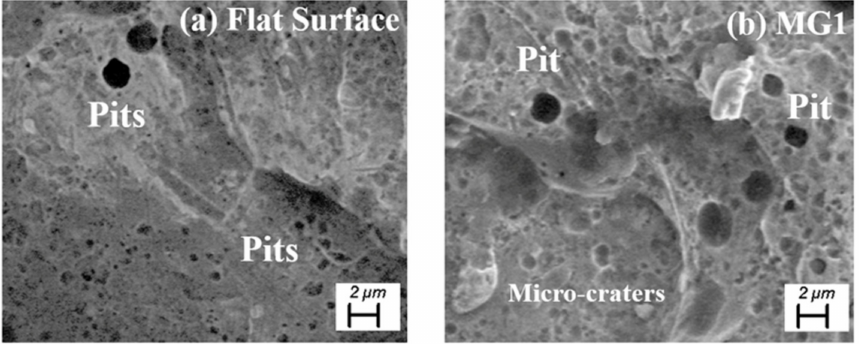
Figure 9. Representative SEM images of ( a ) flat surface and ( b ) MG1 surface taken after corrosion test (after continuous exposure to 3.5 wt. % NaCl solution).